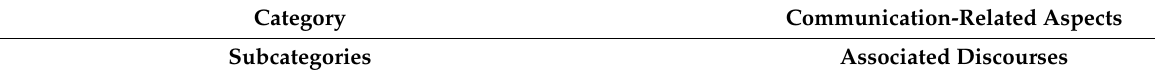
Table 2. Category C: Communication-related aspects. (The figure of the nurse case manager (subsequently CNCM) was created in Andalusia, Spain, in 2002 pursuant to Decree 137/2002 of 30 April on Support for Andalusian Families. Section VII covers support measures for the elderly and/or disabled, including the promotion and improvement of home care to ensure that these individuals can remain at home for as long as possible).